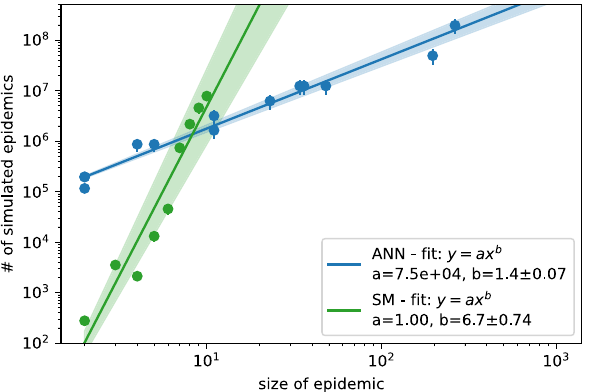
Figure 5. Scaling properties with the size of epidemic cascades. Number of samples generated by the ANN and SM algorithms to reach convergence. We consider the estimation of the marginal probabilities to be infected at time zero with interactions graphs given by a tree of degree and depth both equal to 6 and spanning 15 days of duration. The epidemic cascade are generated with µ = 0 and different values of (cid:31) ( (cid:31) ∈ [ 0.1, 0.6 ] ). For the ANN algorithm, we consider the number of samples generated during the learning process, that is 10 3 samples for each annealing steps (see supplementary material for details). For each instance, we run the annealing process with 2 n number of steps with n ∈ { 5, 6, . . . , 18 } . Each point is a single instance, if the algorithm converges between 2 n − 1 and 2 n steps, the number of samples reported in the plot is the number of steps 2 multiplied by 10 3 samples extracted at each step. For the SM algorithm, each point in the plot is the average number of simulated epidemics necessary to reach convergence to a good estimate of the marginals (worst 10% results were discarded). No point is reported when more than ten infected individuals are observed, because more than 10% of the instances did not converge within 2 · 10 8 simulated